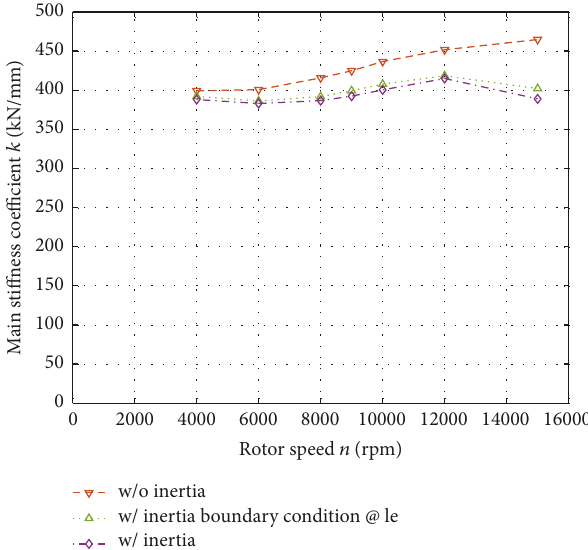
Figure 17: Comparison of predicted synchronous main bearing stiffnessfordifferentsimulationboundaryconditions(TPB120, 𝑝 𝑞 = ∘ C, 𝑧 = 36 mm, and 𝑘 = 2.0 MPa, 𝑄 = 90 l/min, 𝑇 sup = 50 pivot 0.8